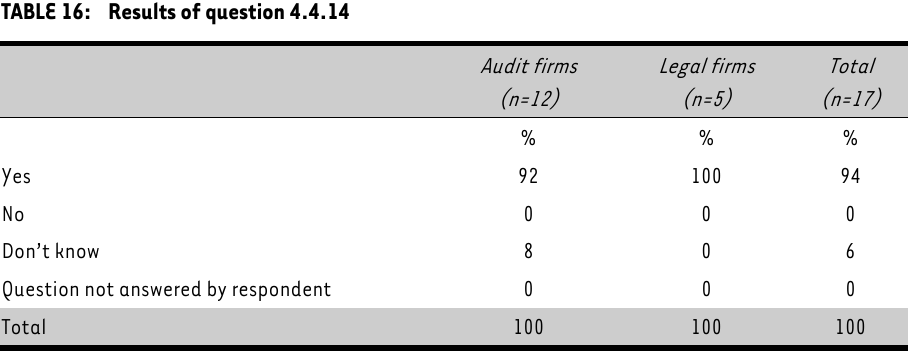
TABLE 16: Results of question